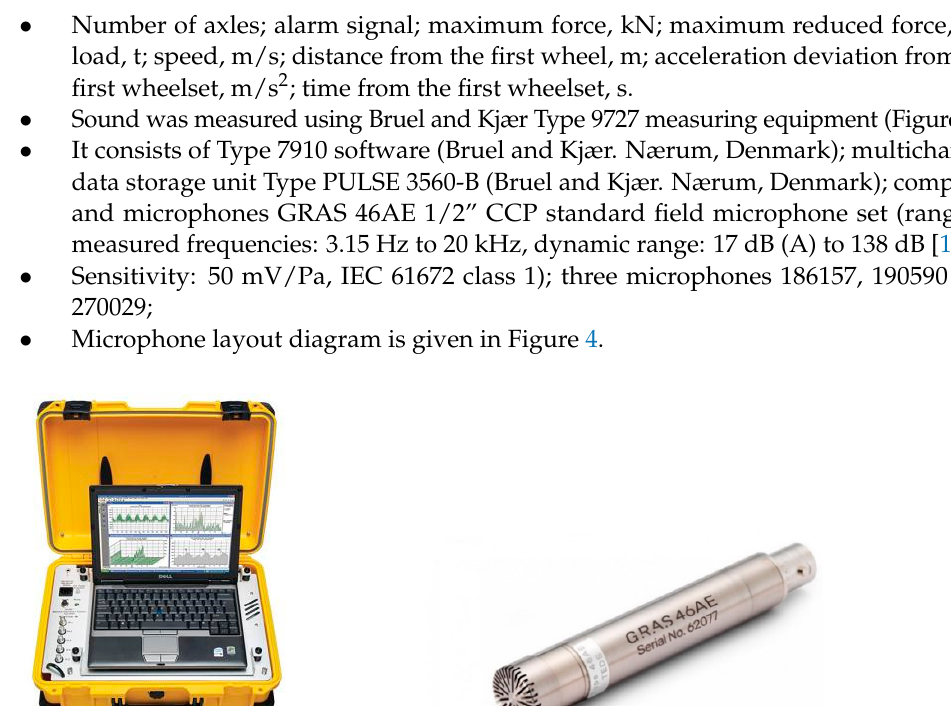
Figure 3. Sound measuring equipment. ( a ) Bruel and Kjær Type 9727 measuring equipment and ( b ) GRAS 46AE 1/2” CCP microphone.